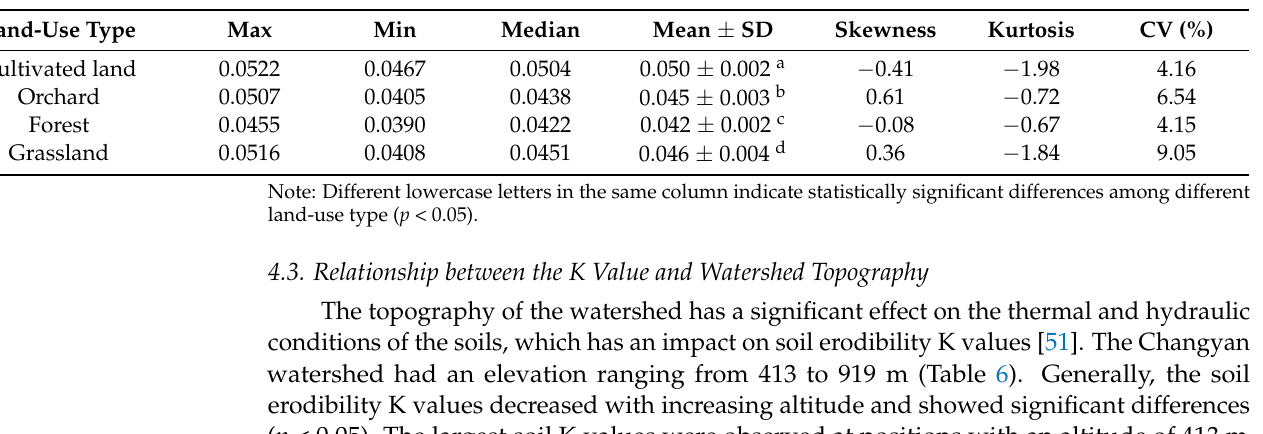
Table 5. Descriptive statistics of K values for different land use types (t·hm 2 ·h/(hm 2 ·MJ·mm)).